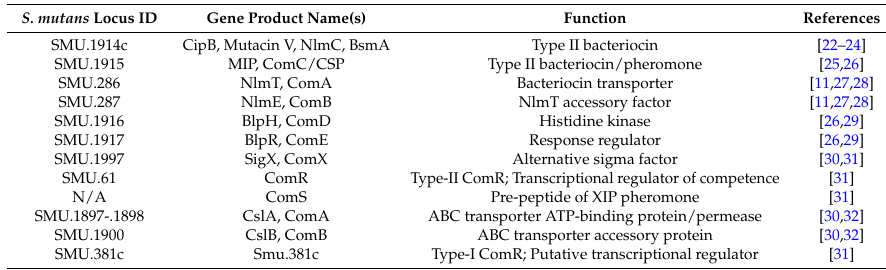
Table 1. Nomenclature of selected genes from the Streptococcus mutans UA159 bacteriocin and competence quorum sensing pathways.